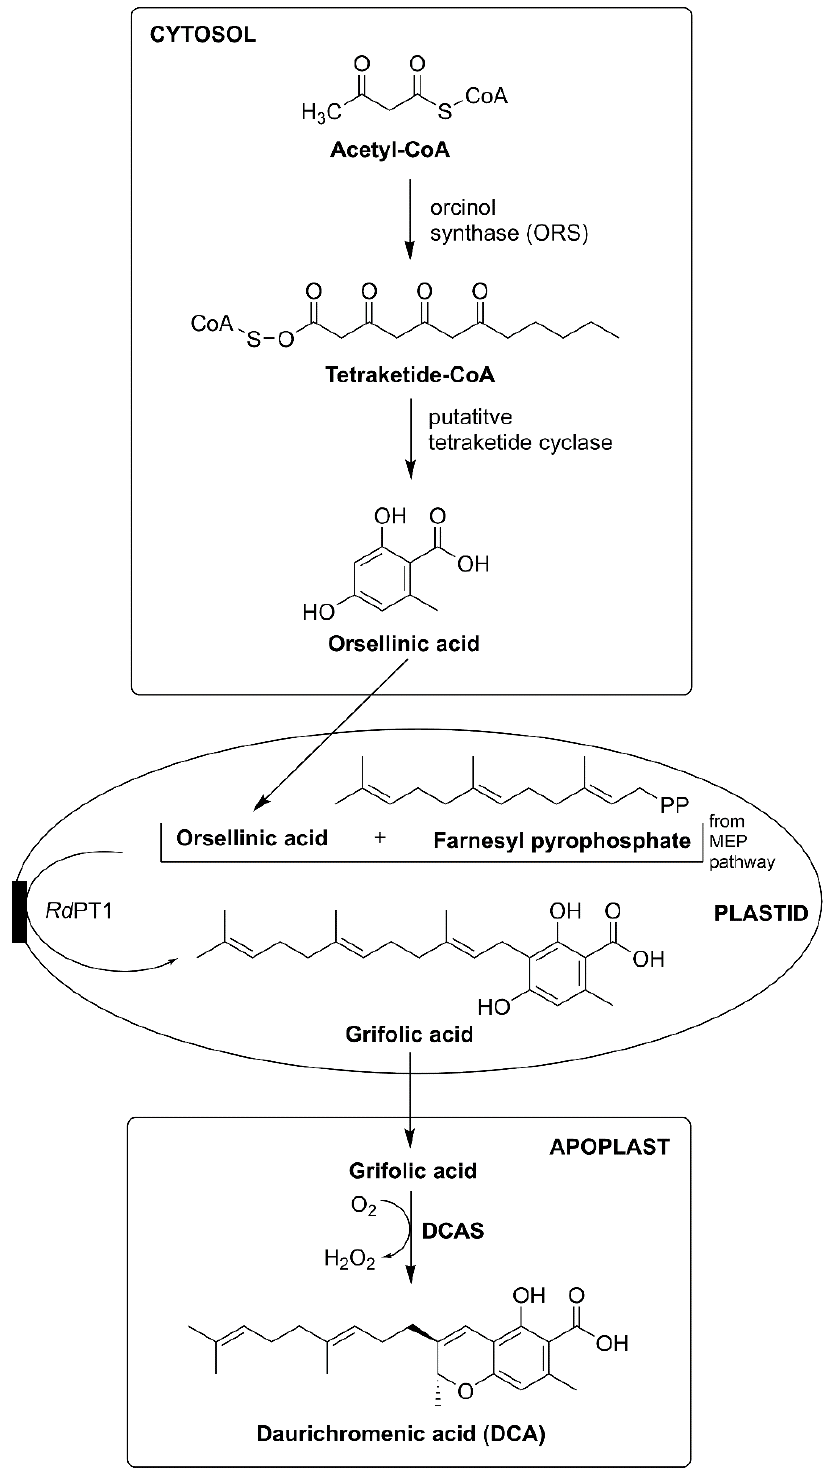
Figure 6. Phytocannabinoids biosynthesis in Rhododendron. Abbreviations: DCAS, daurichromenic acid synthase; MEP, methylerythritol-4-phosphate; PT, prenyltransferase. Apoplastic spaces serve as storage for many metabolites, essential oils, DCA, and confluentin. Moreover, GFA and DCA act as phytotoxic compounds in Rh. dauricum cell culture, as they induce cell death. Similarly, H 2 O 2 formed as a side product in DCA bio- synthesis also increases cell death by enhancing apoptosis-related reactions. However, to overcome cell death, autotoxicity, and cell damage, DCA storage occurs in the apoplast, and H 2 O 2 is released to participate in the plant-defense system and provide plant immun- ity. In Rh. dauricum , transport proteins and vesicle trafficking mechanisms are still not well understood and remain a valuable and exciting approach for further future investigations [1,2,37].